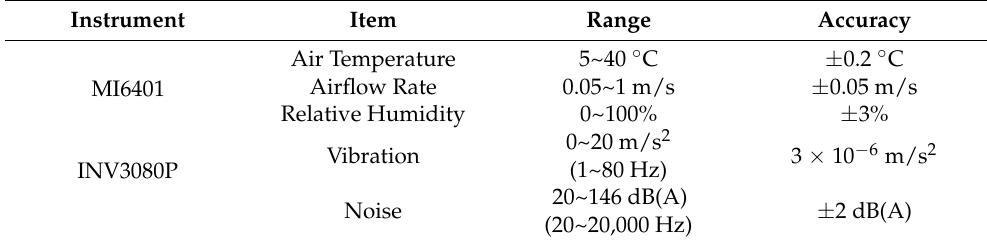
Table 1. Instrument-related